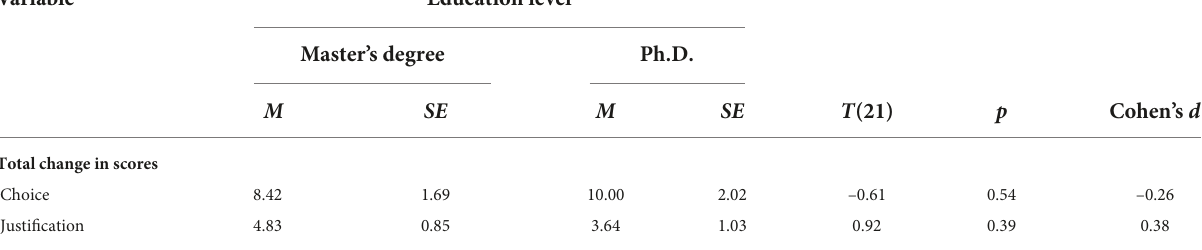
TABLE 5 Independent t -test results for education level. Variable